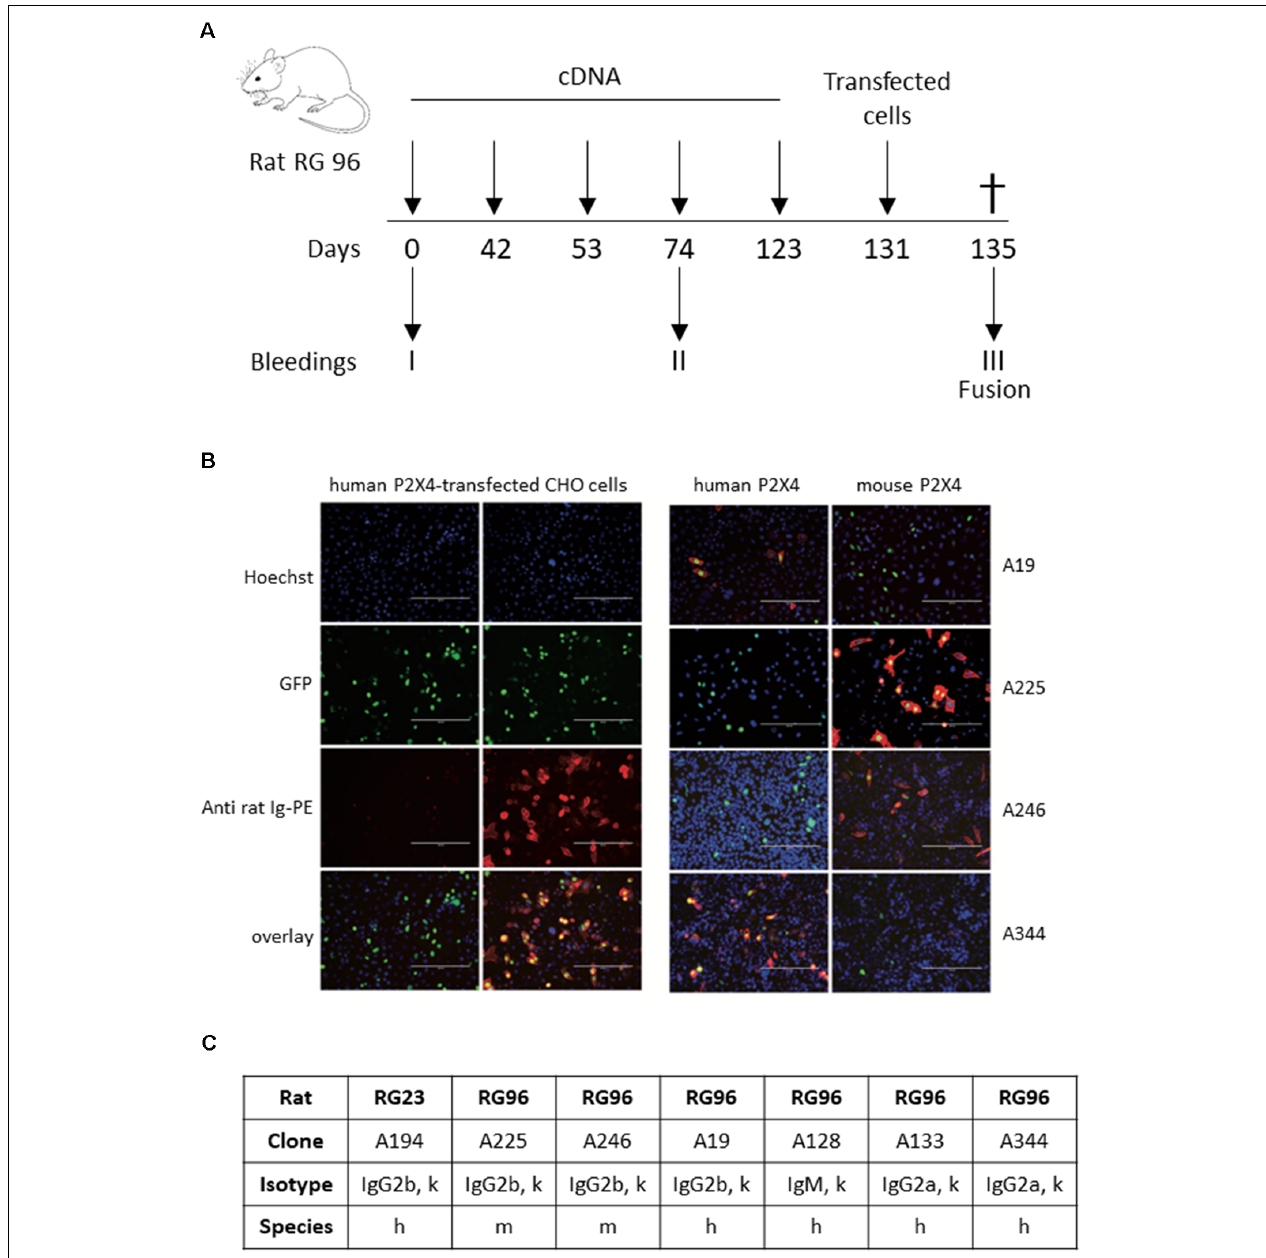
FIGURE 1 | Identification of P2X4-specific monoclonal antibodies. (A) Schematic diagram of the rat immunization protocol. Rats were immunized five times by trans-dermic biolistic gene delivery (six shots per immunization) with expression vectors encoding either mouse WT P2X4 (rat RG23) or mouse and human P2X4-Y378F (rat RG96). Each rat received a final injection of CHO cells expressing either mouse P2X4 or a mixture of mouse and human P2X4-Y378F. Pre-immune sera were drawn at day 0 and immune sera at day 74, prior to the final boost at day 123. Terminal bleeding was performed on day 131, followed by cell fusion and hybridoma selection. (B) Pre-immune sera, immune sera (left panels, dilution 1/1,600) of rat RG96 and hybridoma supernatants derived from RG96 (right panels) were tested for reactivity with CHO-cells transiently co-transfected with expression constructs for nuclear GFP and either human P2X4 or mouse P2X4-Y378F, as indicated. Different hybridoma show specificity toward human or mouse P2X4 receptors. Scale bar: 200 µ m. (C) Specific characteristics of the different identified hybridoma.